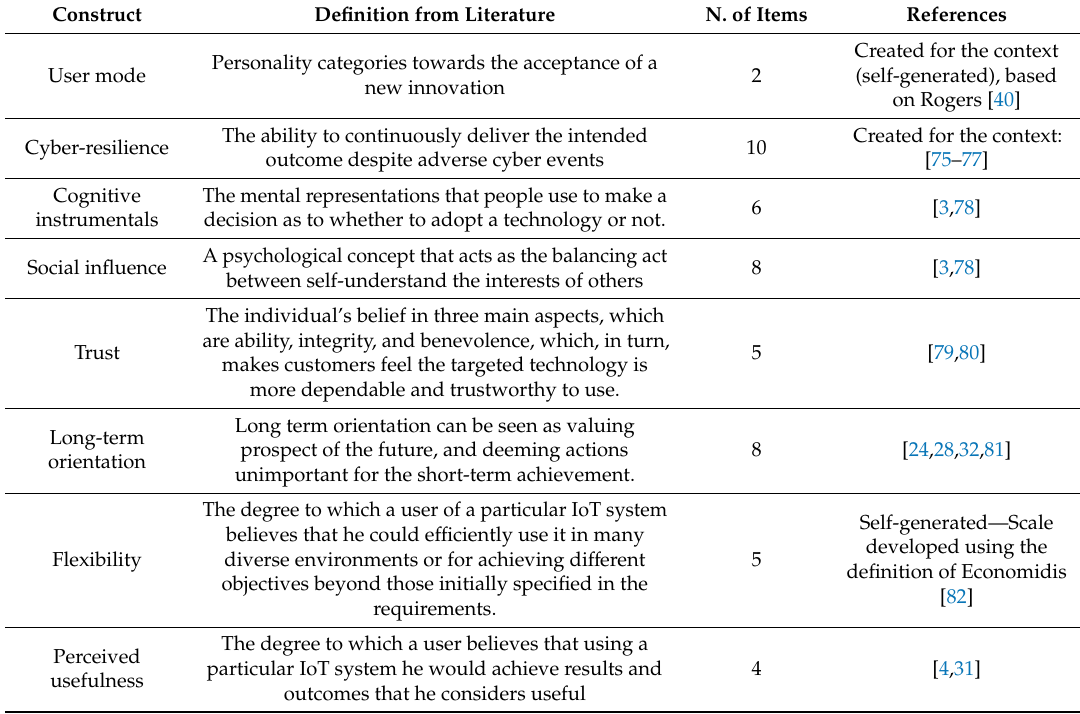
Table A1. Constructs Definitions, Number of Measurement Items and Key